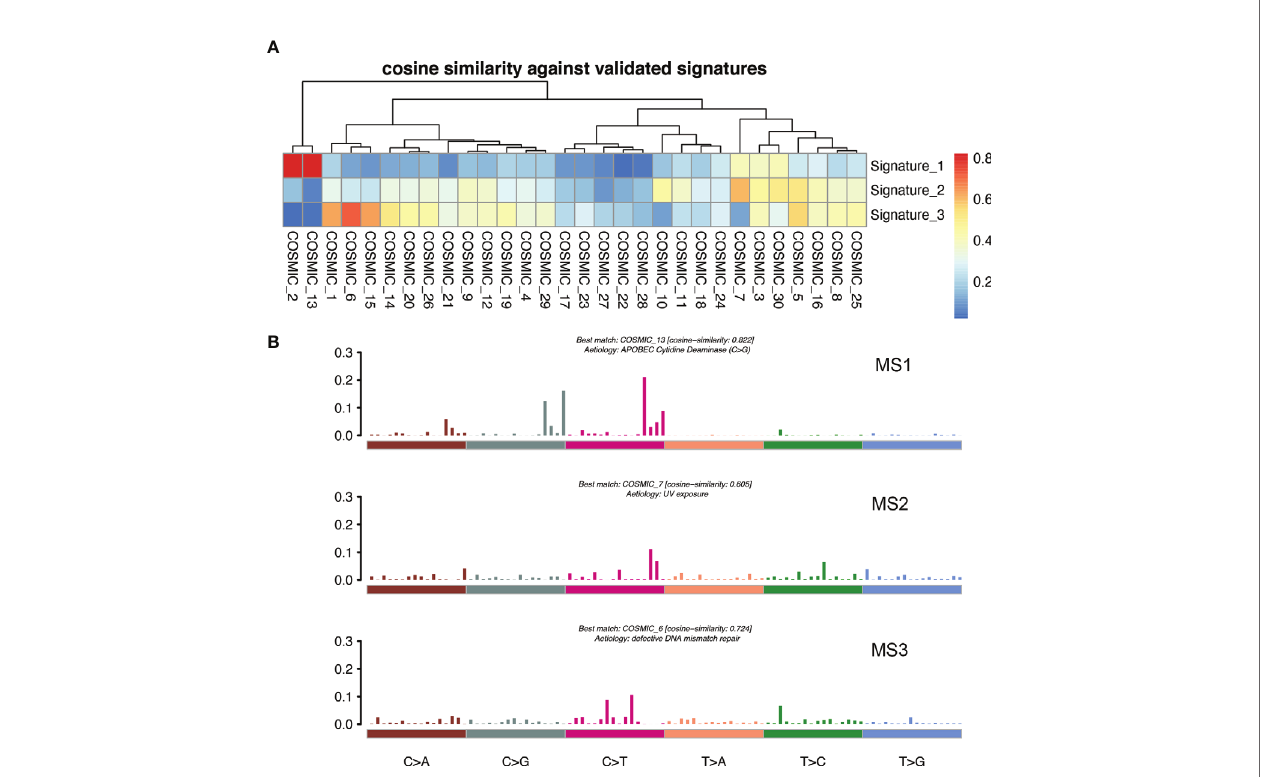
FIGURE 7 | MSs in patients with LM. (A) Correlation between the MSs derived from the patients with LM and previously de fi ned signatures from COSMIC. A pair- wise cosine correlation was performed between the COSMIC and LM signatures. The most correlated COSMIC signatures were used to determine the identity of each LM signature. (B) Three MSs identi fi ed in patients with